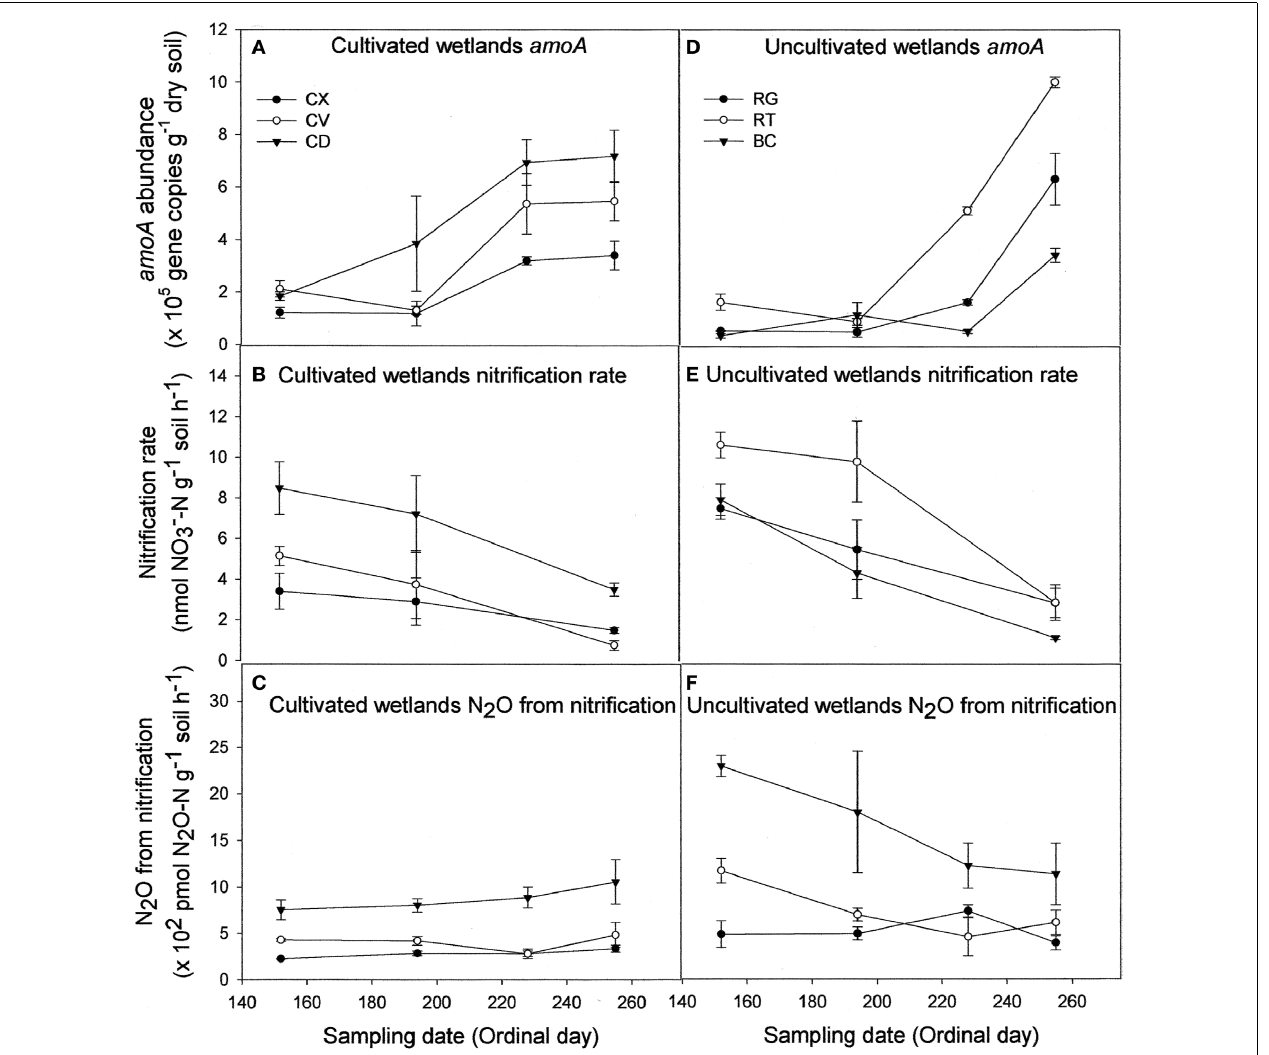
area covered with grasses (RG) and an outer region consisting of trees of shrubs (RT). Based on profile curvature, BC elements are analogous to CD elements, and RT elements are analogous to CV elements. Riparian grass (RG) elements and CX elements represent the driest landforms within the respective wetland type. Reported values are means ( n = 3) with SE